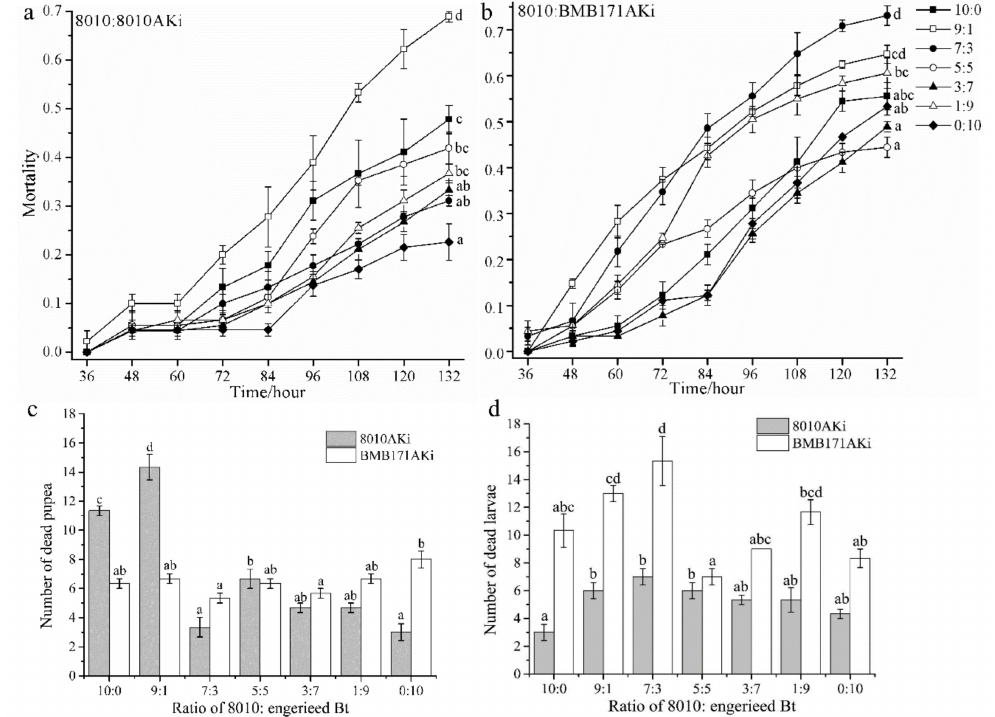
Figure 3. Mortality of P. xylostella caused by the mixtures of Bt 8010 and engineered Bt expressing dsRNA of PxAK . The mortality of P. xylostella caused by the bacteria mixtures in different ratios were collected every 24 h and three biological replications were performed for each treatment. the mixtures of Bt 8010 and engineered Bt in different ratios were recorded and three biological replications were performed for each treatment. ( c ) Pupae; ( d ) Larvae. The bars represent the mean ± SE of each treatment. Different lowercase letters represent significant differences among the mixtures of different ratios for 8010:8010AKi and 8010:BMB171AKi separately by Tukey test in one-way ANOVA ( p <